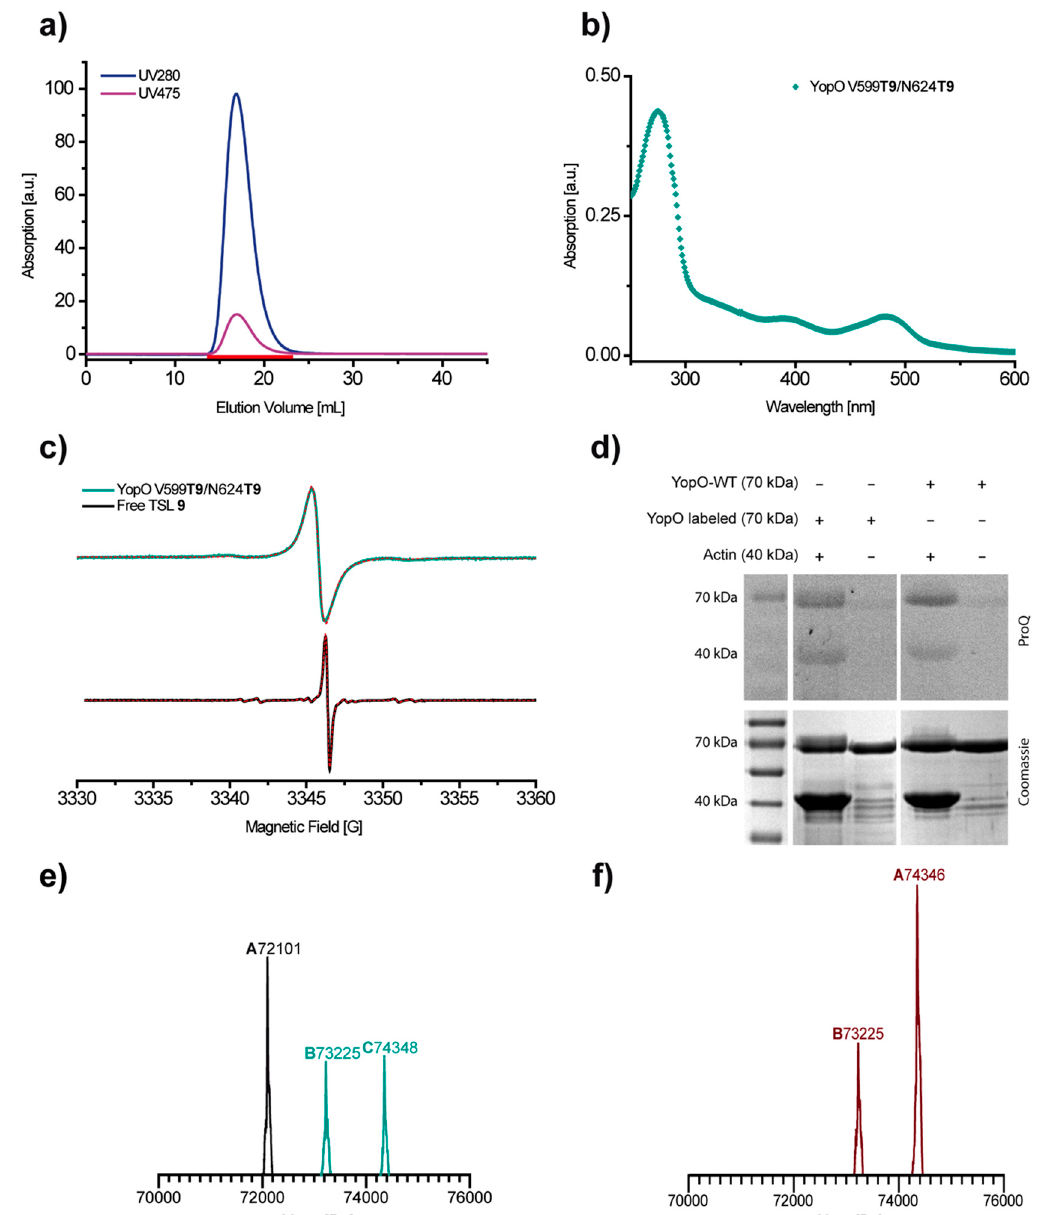
Figure 6. The labeling of YopO V599C/N624C with 9 . The analytics after the separation of the free label via PD-10 column. ( a ) HiPrep 26/10 size exclusion chromatogram of the labeled protein showing the trityl specific absorption at ~475 nm (red) and the absorption at 280 nm (blue). ( b ) UV/Vis spectrum of the labeled protein. The absorption maxima at ~475 nm and at ~280 nm are calculated to represent a concentration ratio of 9 to YopO of 1.8/1, i.e., 90% labeling efficiency. ( c ) The room temperature X-band cw EPR spectrum of the labeled protein YopO V599 T9 /N624 T9 (mint) as compared to the free label (black). The dashed red lines indicate spectral simulations obtained with EasySpin (Supplementary Materials, Section 8.2) [76]. EMXmicro acquisition parameters: modulation amplitude 0.15 G, microwave power 2.783 mW, time constant 20.48 ms, sweep time 42.04 s, resolution 67 pts/G. ( d ) The phosphorylation assay of labeled YopO V599 T9 /N624 T9 in comparison to YopO-WT. The phosphorylation is detected using ProQ Diamond stain and subsequent Coomassie staining. ( e ) ESI(+)-MS of the intact protein YopO V599 T9 /N624 T9 . The doubly labeled protein calculated: 74347.6 Da, found: 74348 Da (peak C ). ( f ) ESI(+)-MS of the intact protein YopO S585 T9 /Q603 T9 . The doubly labeled protein calculated: 74345.6 Da, found: 74346 Da (peak A ).